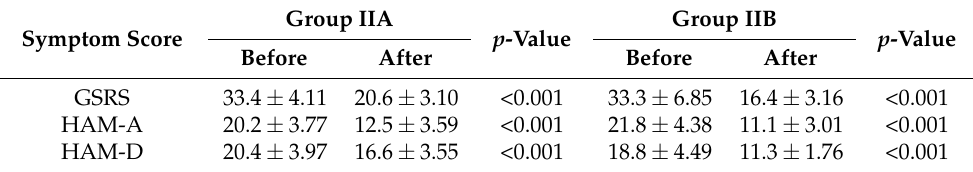
Table 4. Comparison of severity of symptoms between the two subgroups of IBS-D patients (Group IIA without and Group IIB with tryptophan limitation intake) before and after nutritional intervention; GSRS—Gastrointestinal Symptom Rating Scale; HAM-A—Hamilton Anxiety Rating Scale; HAM-D— Hamilton Depression Rating Scale; average ± SD.